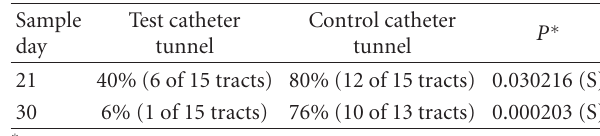
Table 6: Infection prevention in the tissue samples: the total number of samples where significant ( ≥ 3.0 Log) bacterial load was recovered (from sample locations 4, 6, 8, and 10) is divided by the total number of catheters/tracts in each group. This is separated by sample type (tissue and catheter).